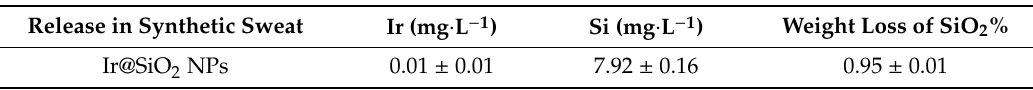
Table 2. Release values in synthetic sweat of Ir@SiO 2 -coated fabric after 24 h in static condition at 32 ◦